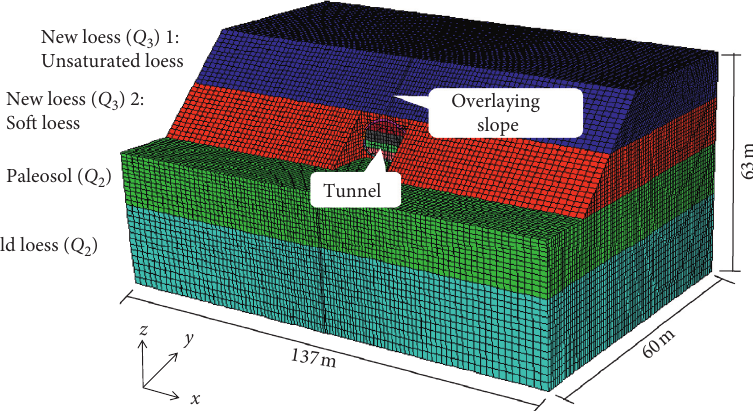
Figure 21: Computation model